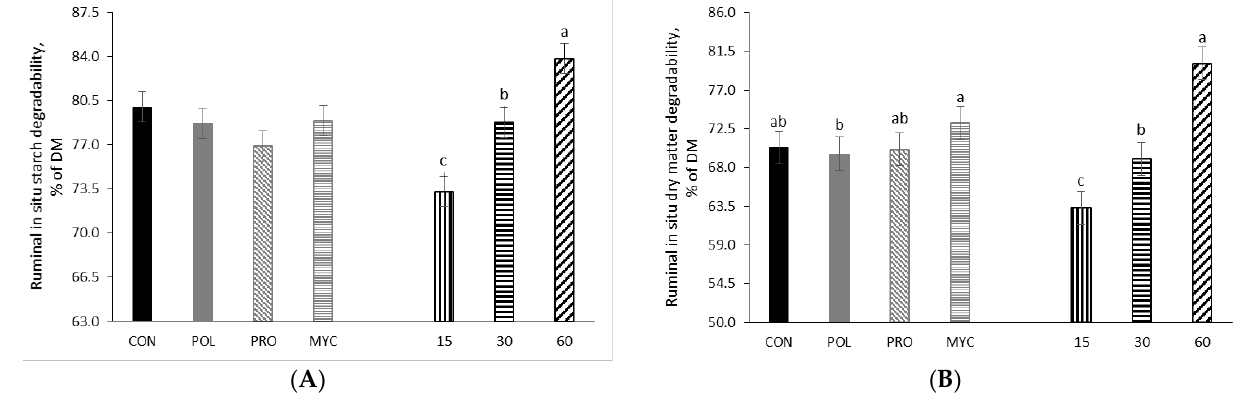
Figure 6. Ruminal in situ starch degradability in 12 h of reconstituted corn grain silage ensiled for 15, 30 or 60 d, without additives treatment (CON), or treated with polysorbate 80 (POL), propionic acid (PRO) or polysorbate 80 and propionic acid (MYC). Statistical effects observed for ( A ) Ruminal In situ starch degradability in 12 h – Additive, p = 0.07, SEM = 1.03; Storage, p < 0.01, SEM = 0.94; A × S, p = 0.71; ( B ) Ruminal In situ dry matter degradability – Additive, p = 0.02, SEM = 0.89; Storage, p < 0.01, SEM = 0.78; A × S, p = 0.60. Different letters differ by Tukey’s test ( p ≤ 0.05) .